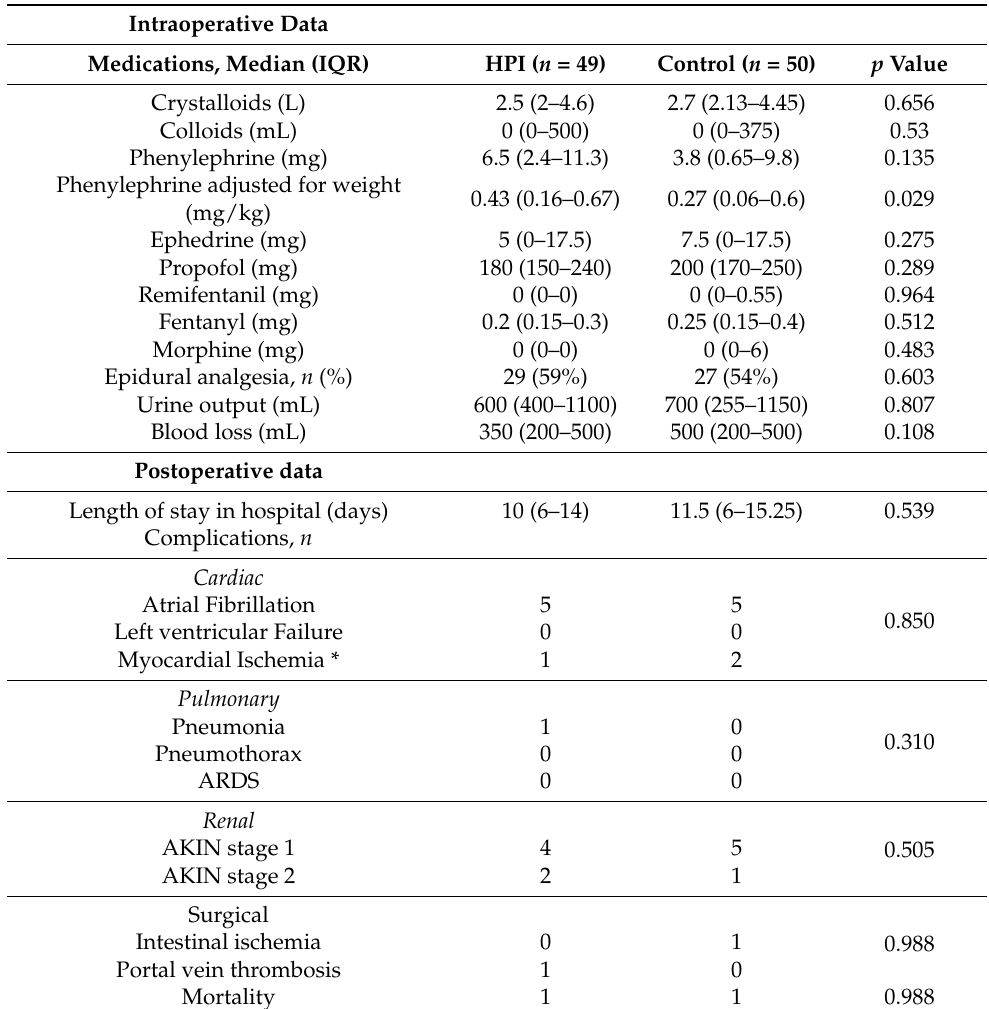
Table 3. Intraoperative drug use and postoperative